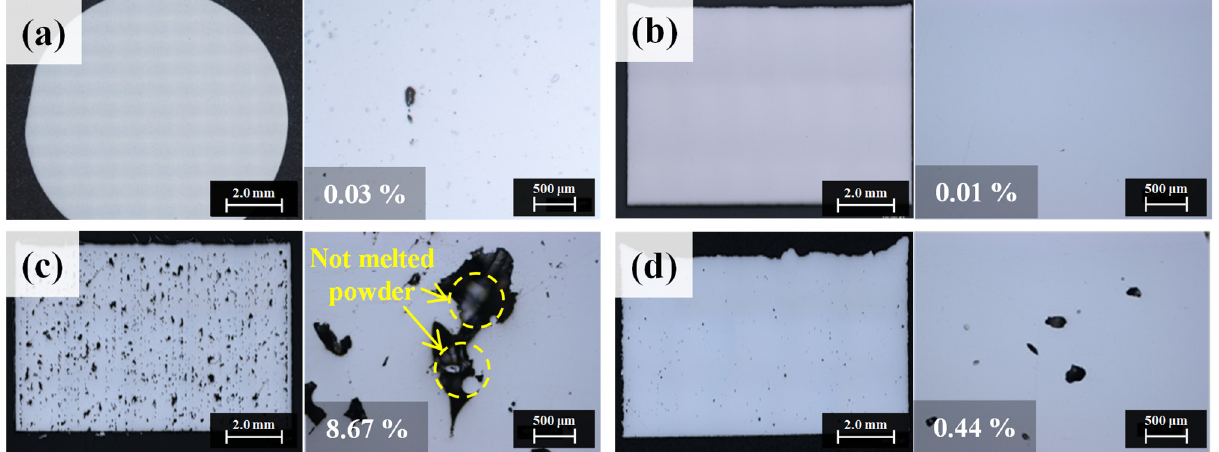
Figure 5. ( a ) Cross-sectional porosity result of Hastelloy X cast specimen, cross-sectional porosity results of laser power bed fusion (LPBF) process window map: ( b ) void-free cross section in the stable region, ( c ) lack of fusion defects primarily occurring in the low energy density region, ( d ) keyhole defects primarily occurring in the high energy density region.